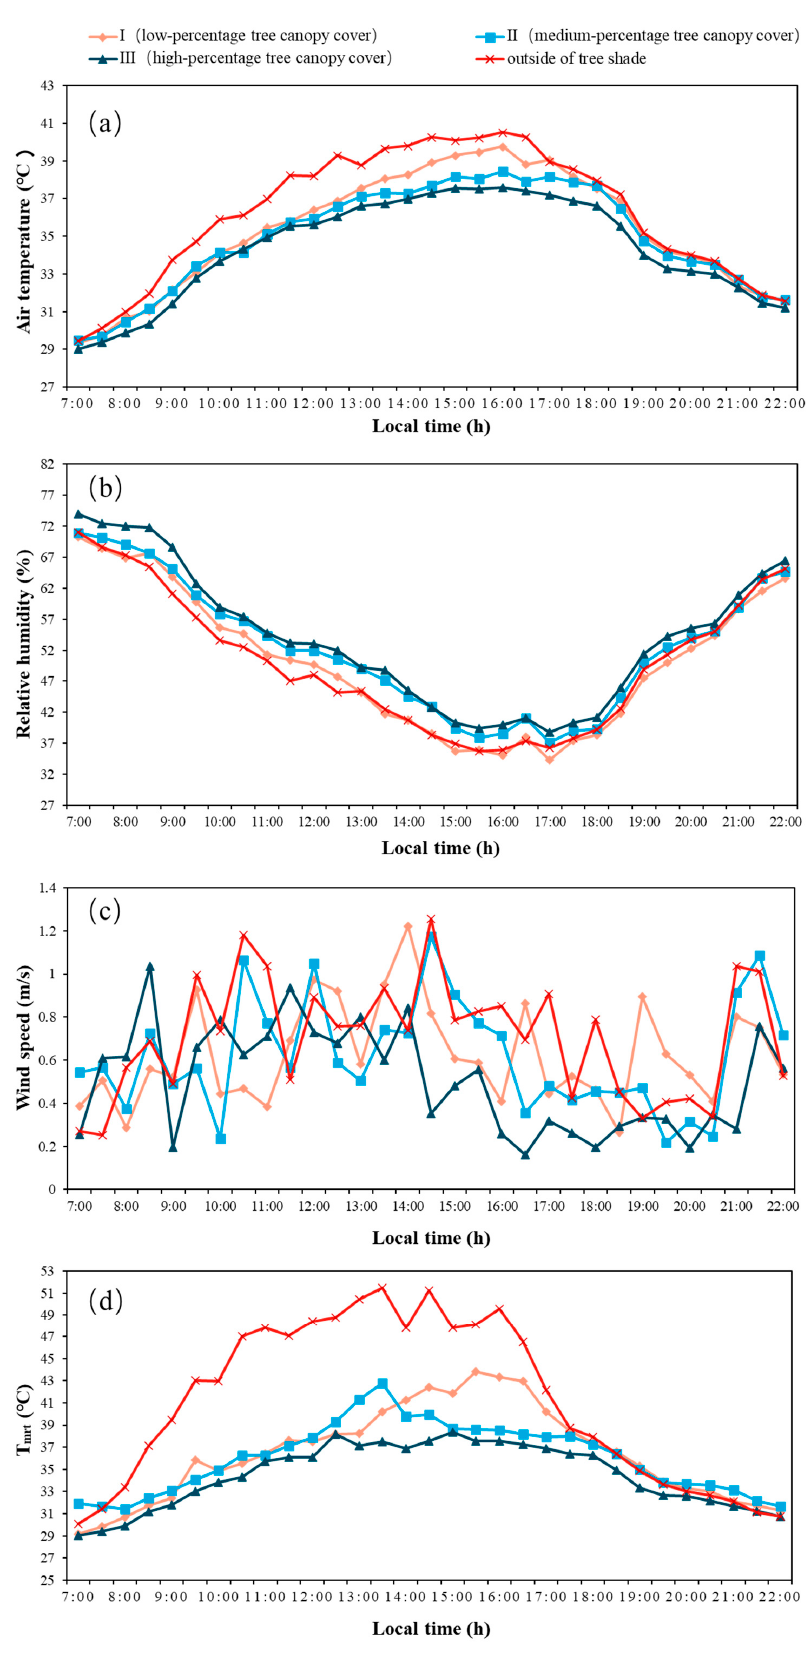
Figure 5. Changes in microclimatic factors under di ff erent degrees of tree canopy cover: ( a ) Average air temperature; ( b ) average relative humidity; ( c ) average wind speed; ( d ) mean radiant